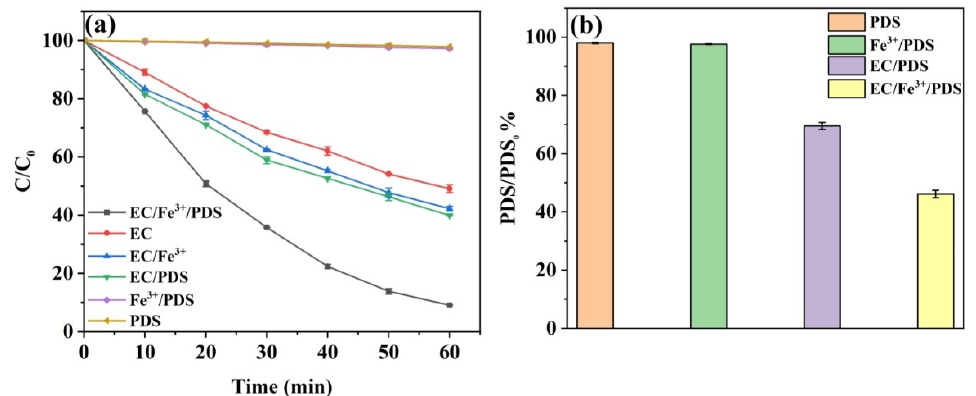
Figure 1. IBU removal ( a ) and remaining percentage of PDS ( b ) under different systems; ((initial IBU concentration) = 30 mg/L, (Fe 3+ concentration) = 1 mM, (PDS concentration) = 8 mM, current density = 15 mA/cm 2 , initial pH = 3).